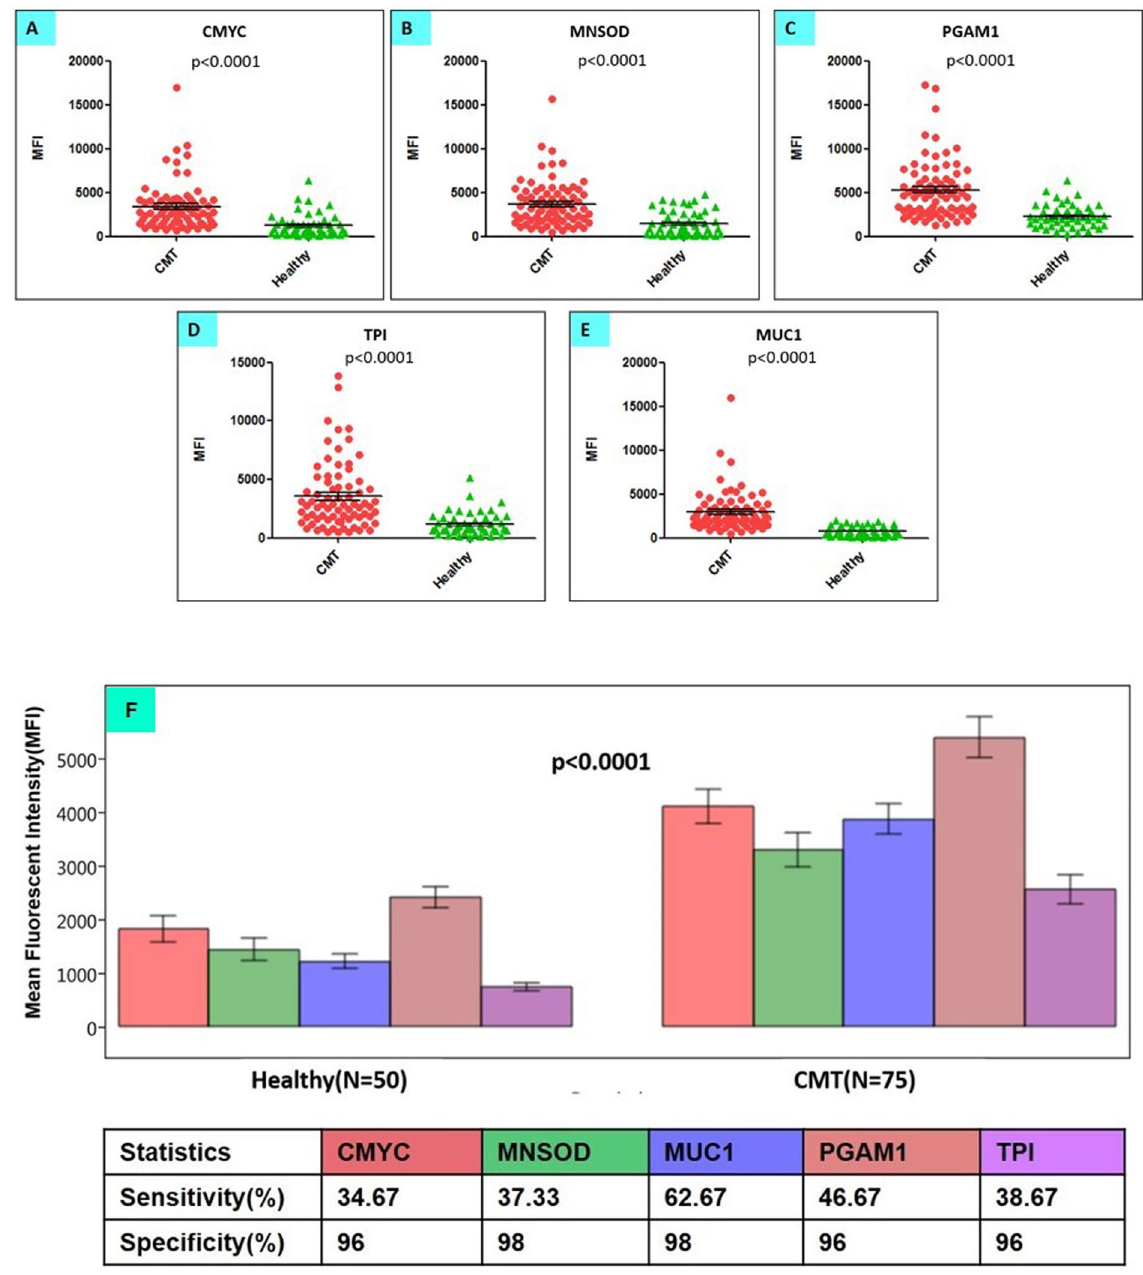
Figure 6. Comparison of MFI values corresponding to autoantibody response (against five TAAs) in 50 healthy and 75 canine mammary tumour sera. ( A – E ) Scatter diagrams representing CMYC, MNSOD, PGAM1, TPI & MUC1 autoantibody response in canine mammary tumour (CMT) sera (n = 75) and healthy dog sera (n = 50). ( F ) At 1:200 dilution of sera samples, the multiplex assay comprising of 5 autoantigens, namely TPI, PGAM1, MUC1, MNSOD, & CMYC coupled microspheres, produced significantly higher average MFI signals in CMT sera (n = 75) compared to healthy dog sera samples (n = 50) (Mann-Whitney, p value < 0.0001). At cut-off value (avg. MFI of healthy sera + 2 SD), individual assays were found to be highly specific (96–98% specificity). The bars represent average MFI values and error bars represent standard